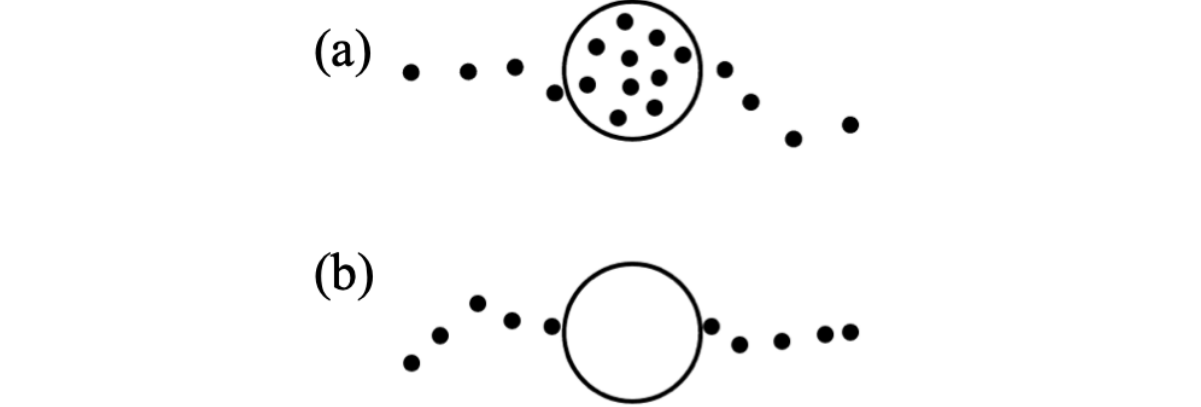
Figure 1. Stop types: (a) full-signal stop and (b) no-signal stop.